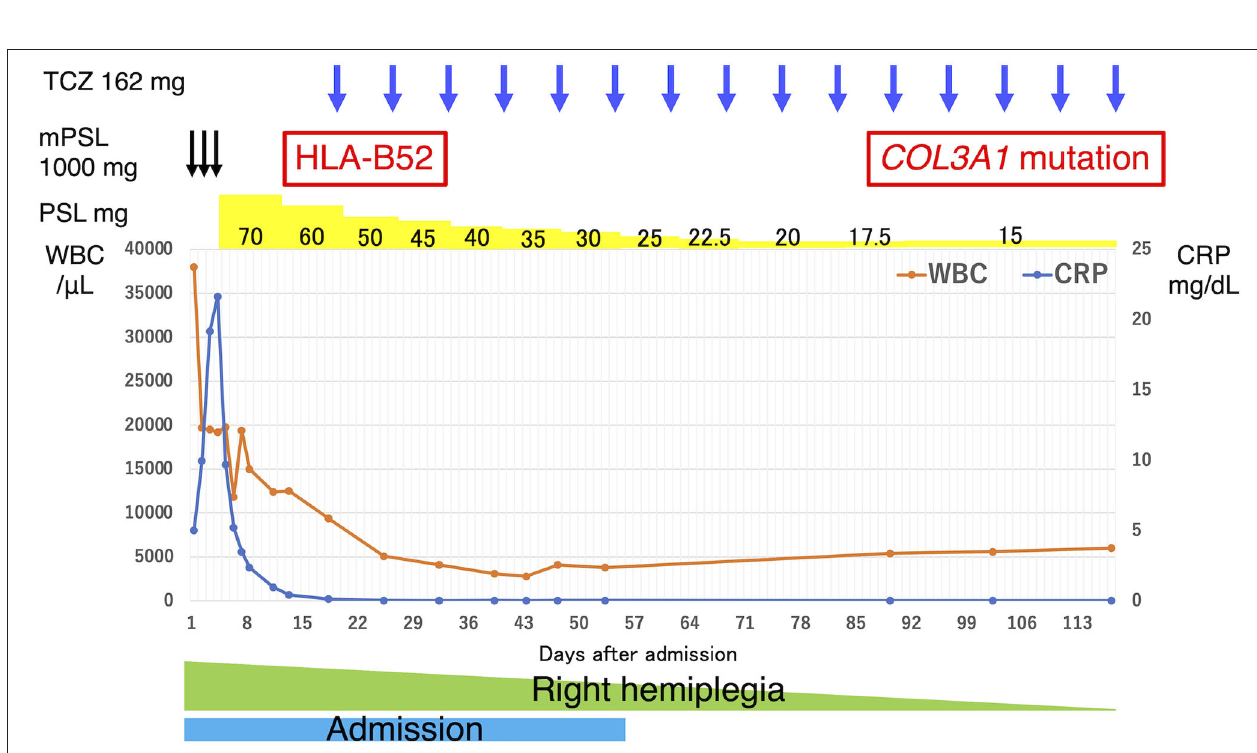
FIGURE 3 | Clinical course of our patient. The vertical axis of the graph represents the WBC count and CRP levels, and the horizontal axis represents the number of days since admission. The drug content, dosage, dosing interval, and results of the generic tests are noted above the graph. The duration of admission and hemiplegia are shown in the graph. CRP, C-reactive protein; TCZ, tocilizumab; mPSL, methylprednisolone; PSL, prednisolone; WBC, white blood cell.